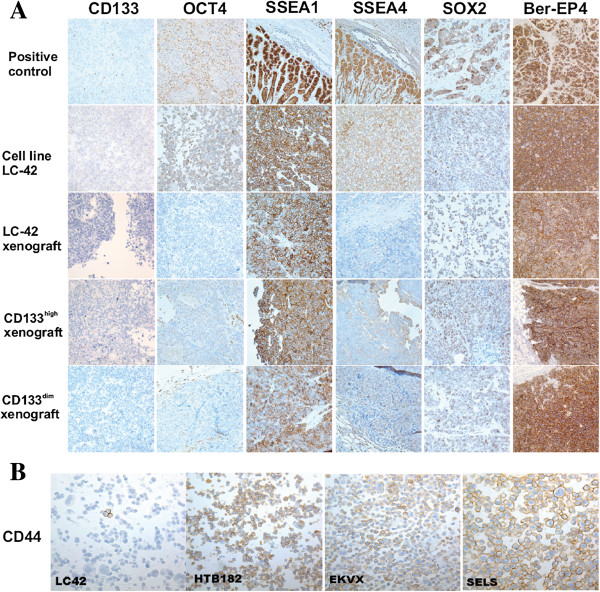
IHC analysis of CD133, OCT4, SSEA1, SSEA4 and SOX2 in xenografts from different cell fractions. A. IHC analysis of CD133, and the stem cell related transcription factors OCT4, SSEA1, SSEA4 and SOX2 in parental LC-42 cells, corresponding xenograft, and xenografts derived from CD133high and CD133dim cells. The xenografts resemble their parental LC-42 cells for the expressions of CD133, OCT4, SSEA1, SSEA4 and SOX2. B. IHC analysis of CD44 expression in 4 lung cancer cell lines LC-42, HTB-182, EKVX and SELS. All the representative images are at 40× magnifications.